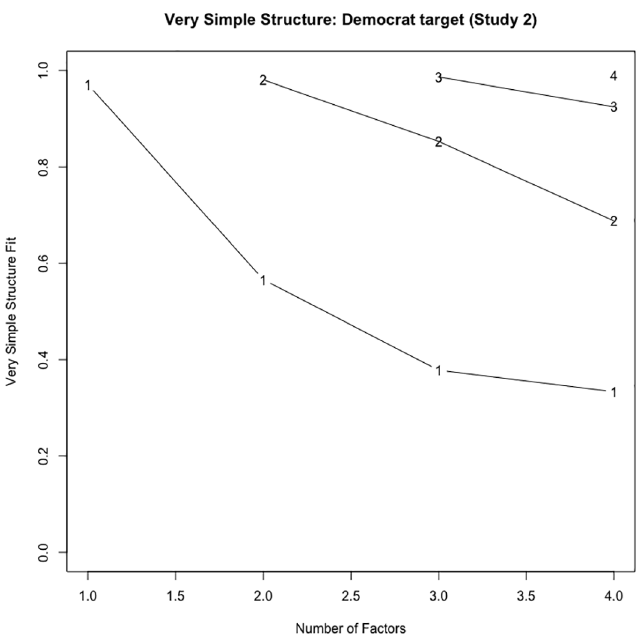
Figure A.3. Very simple structure analysis of Democrat target trait ratings in Study 2.